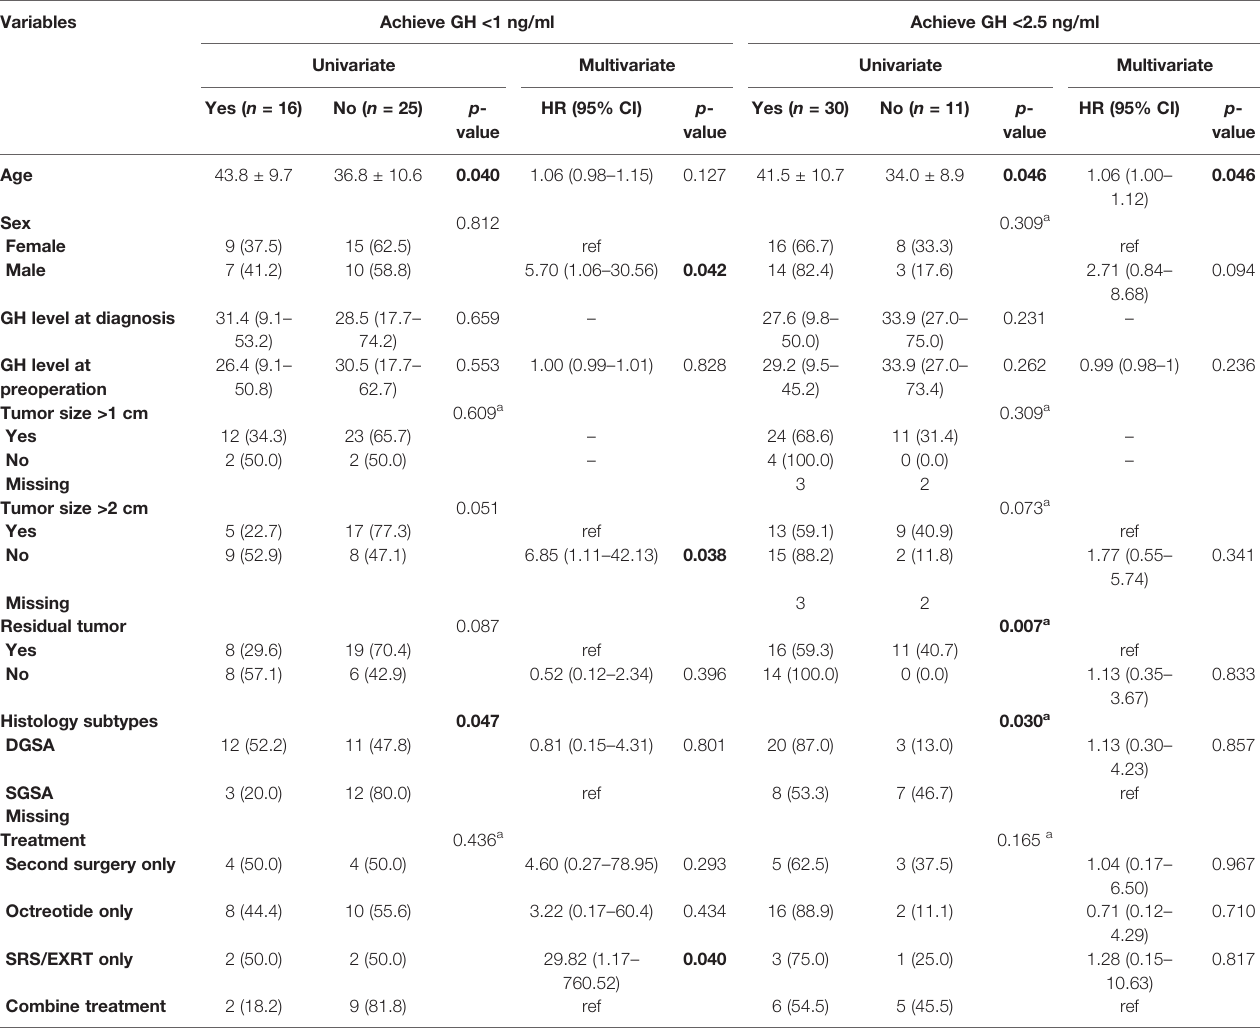
TABLE 5 | Factors associated with remission at fi nal follow-up time for patients failed fi rst TSA operation in univariate and multivariate analyses ( n = 41).